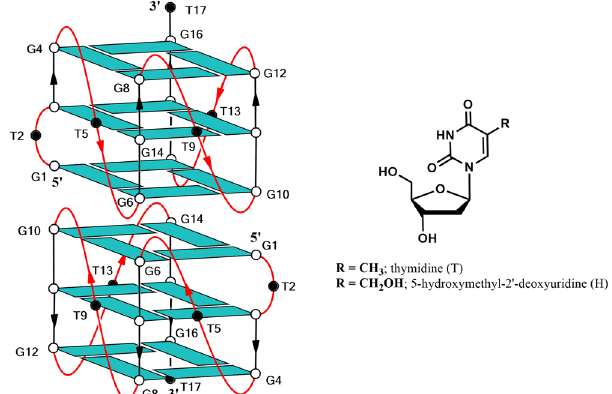
Figure 1. Schematic representation of the dimeric G-quadruplex structure adopted by aptamer T30175 and chemical structure of thymidine (T) and 5-hydroxymethyl-2 ′ -deoxyuridine (H), introduced in positions 2, 5, 9, 13 and 17. All the guanosines adopt anti glycosidic conformations (in light blue). The thymidines are represented as black